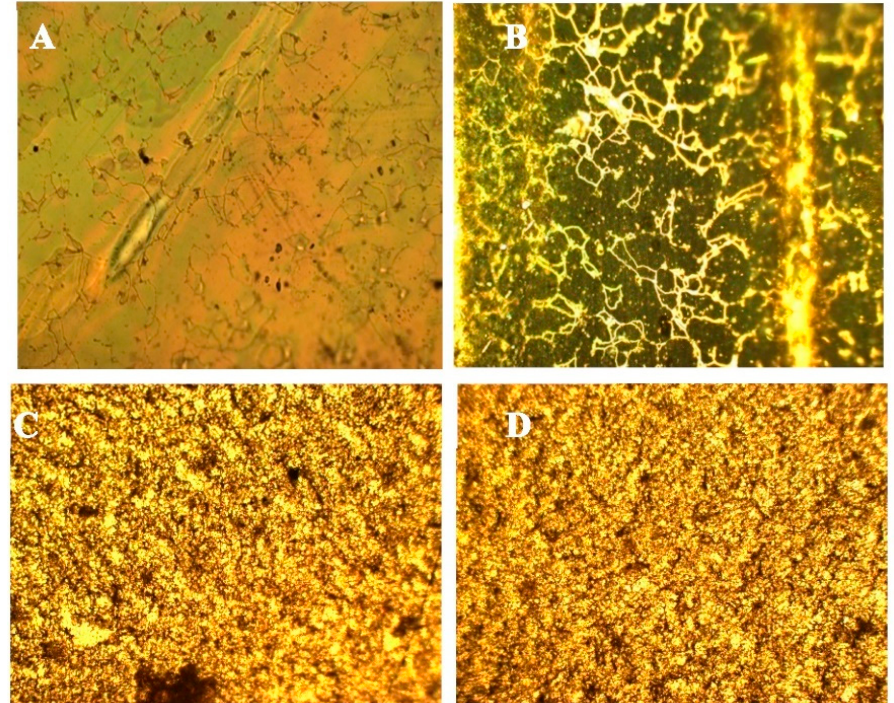
Figure 4. Optical images of Azo-LC-PMP ( A , B ) and doped PMP ( C , D ) obtained by polarized light microscope measured by putting the respective samples at 45 degrees ( A , C ) or parallel to one of the two polarizers ( B , D ). Table 1. Transmissivity of bare and doped PMP when the director n was parallel to the polarizers or tilted by 45 degrees, with incident light power P in = 2.5